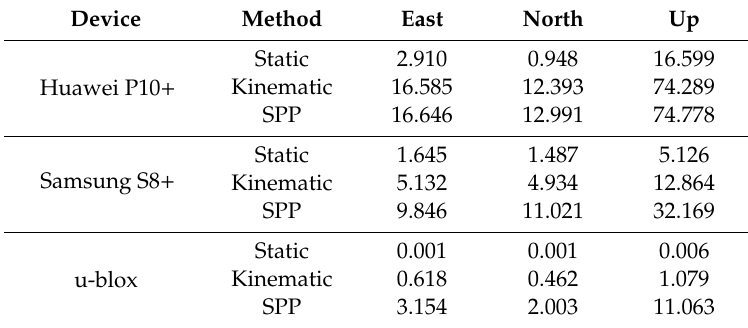
Table 7. Accuracy results of Huawei P10 + , Samsung S8 + , and u-blox for a session length of 30 min. All results exceeding a threshold of 3 m are highlighted inside the table.